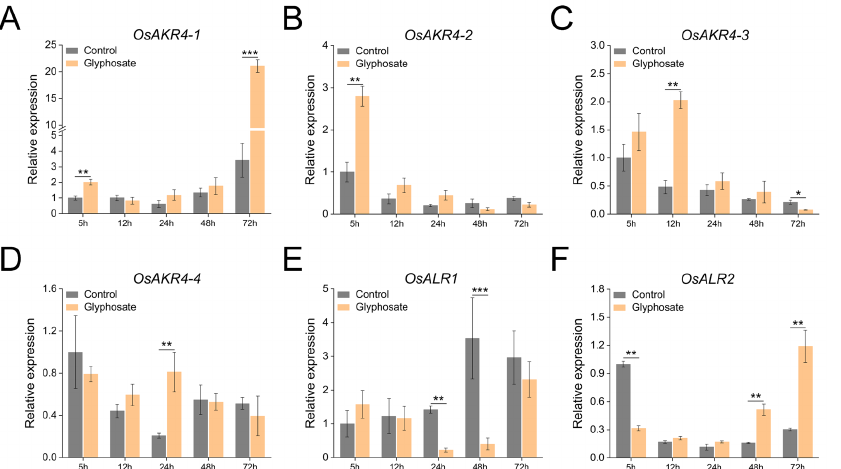
Figure 5. Transcription profiles of OsAKRs in response to glyphosate treatment. ( A ) for OsAKR4-1 . ( B ) for OsAKR4-2 . ( C ) for OsAKR4-3 . ( D ) for OsAKR4-4 . ( E ) for OsALR1 . ( F ) for OsALR2 . Two-week- old rice seedlings were sprayed with 13 mM glyphosate, and RNA was extracted from the shoots at 5, 12, 24, 48, and 72 h after treatment. Data are mean ± standard deviation, n = 3. (* p < 0.05, ** p < 0.01, *** p < 0.001; Duncan’s multiple range tests).